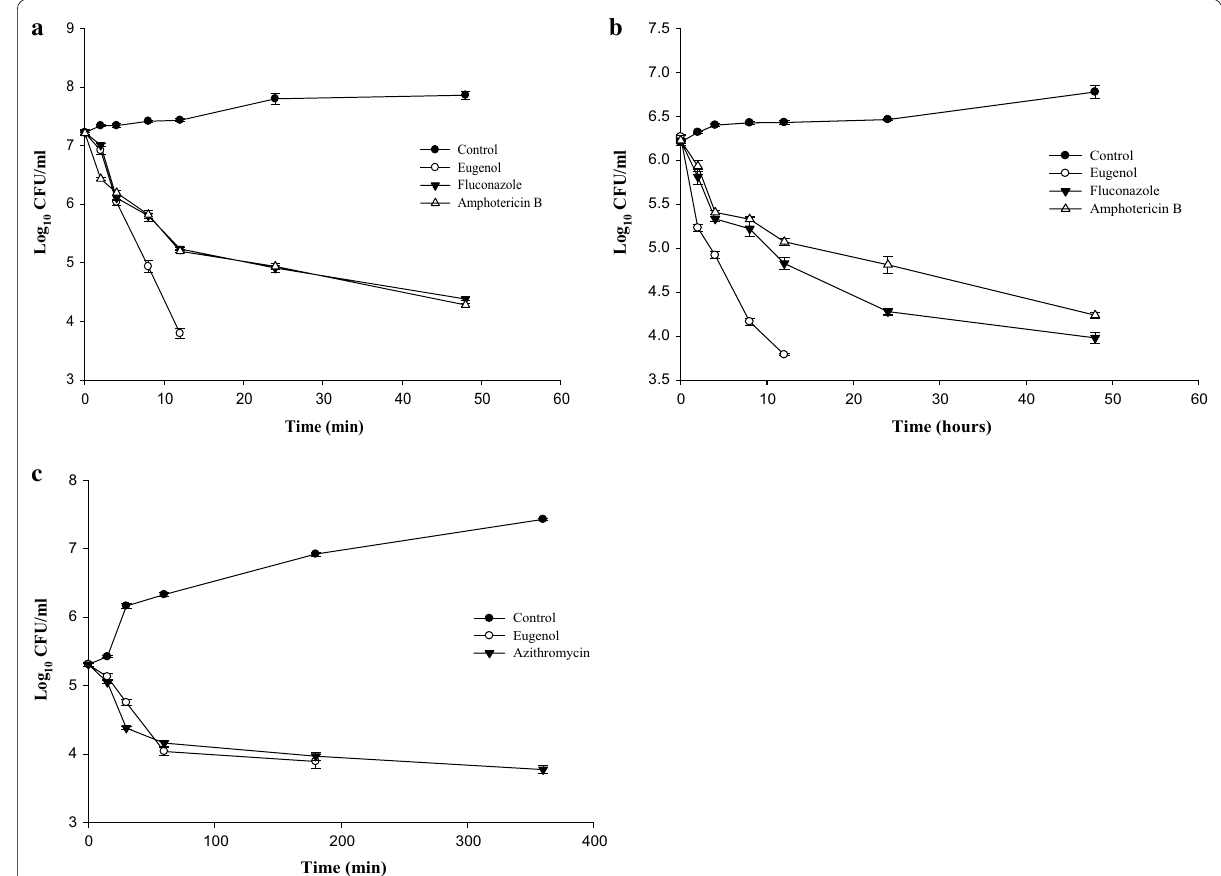
Fig. 3 Time kill curves for eugenol and antimicrobial drugs against pre-formed C. albicans (CAJ-01 and CAJ-12) and S. mutans MTCC497 biofilms. a CAJ-01, b CAJ-12, c S. mutans